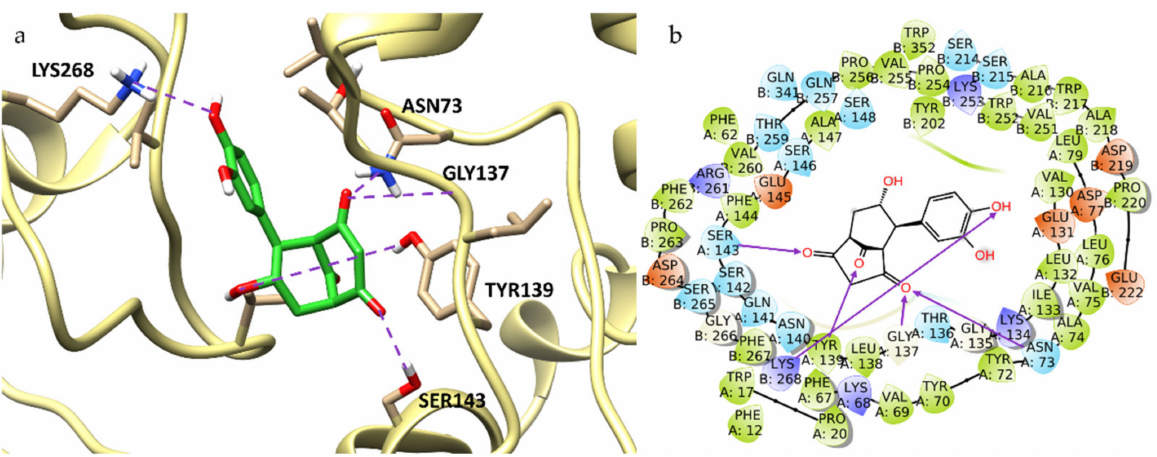
Figure 6. Binding pose ( a ) and interactions ( b ) of catechinic acid at the ToBRFV CP active site. ( a ): the protein is reported as light-yellow ribbons; catechinic acid is reported as green capped sticks. H- bonds are presented as purple dotted lines. ( b ): catechinic acid is surrounded by the protein residues represented as follows: the negatively charged residues are indicated in red, polar residues are in cyan, hydrophobic residues are shown in green, and H-bonds are depicted as purple